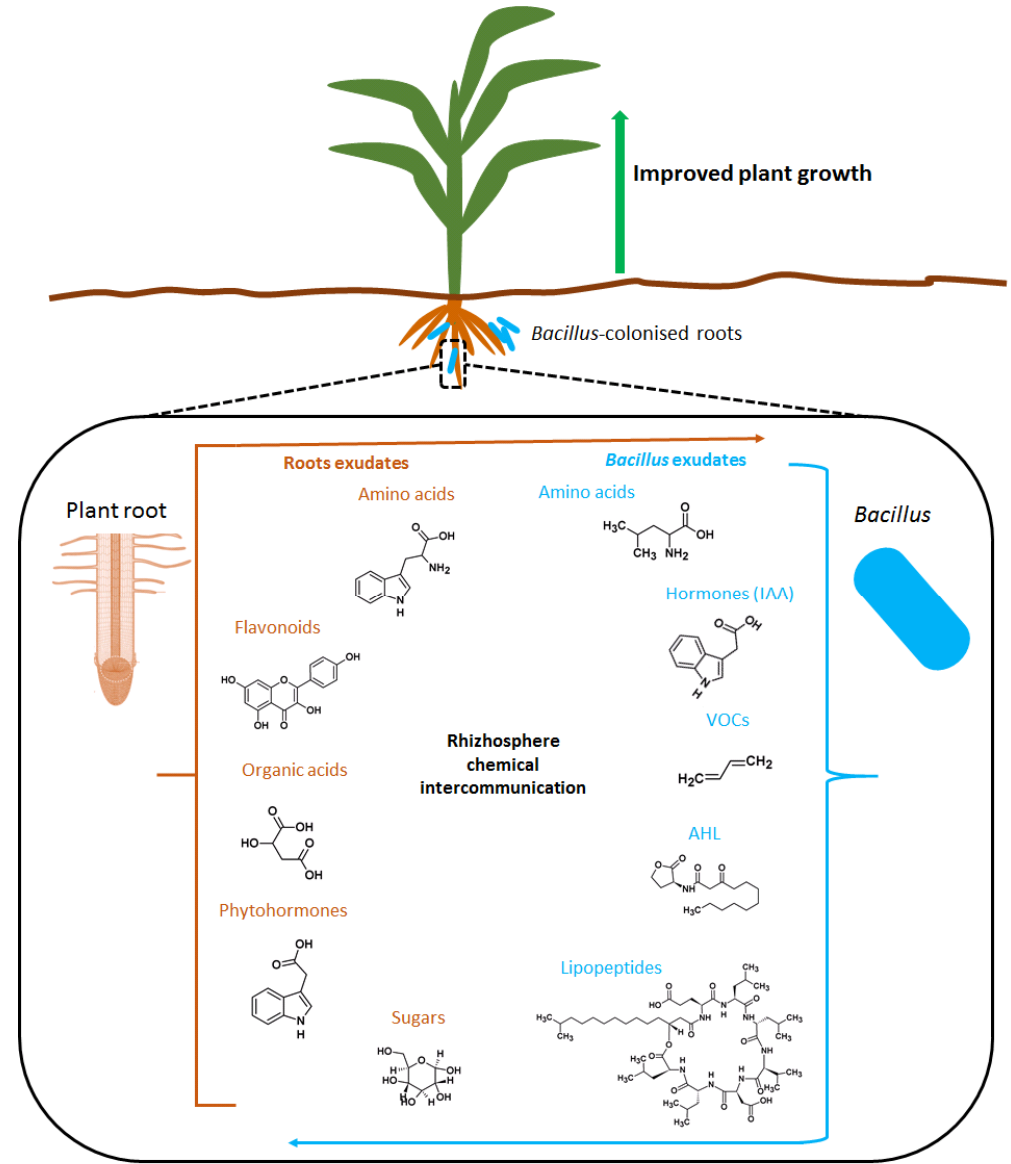
Figure 2. Some molecules involved in Bacillus -plant interactions. Plants produce various compounds including the hormones salicylic acid (SA), jasmonic acid (JA), cytokinins (CK), and indole acetic acid. Plants also produce organic acids, flavonoids, amino acids, and 1-aminocyclopropane-1-carboxylate (ACC) as signaling molecules. On the other hand, Bacillus produce volatiles such as 2,3 butanediol, lipopeptides such as surfactin, and phytohormones such as gibberellic acid and acyl homoserine lactone (AHL) as signaling molecules.